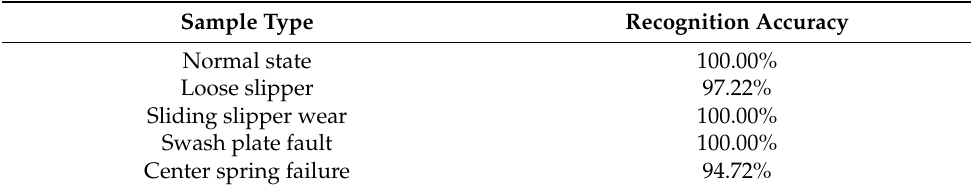
Table 3. The recognition accuracy rate of each state.